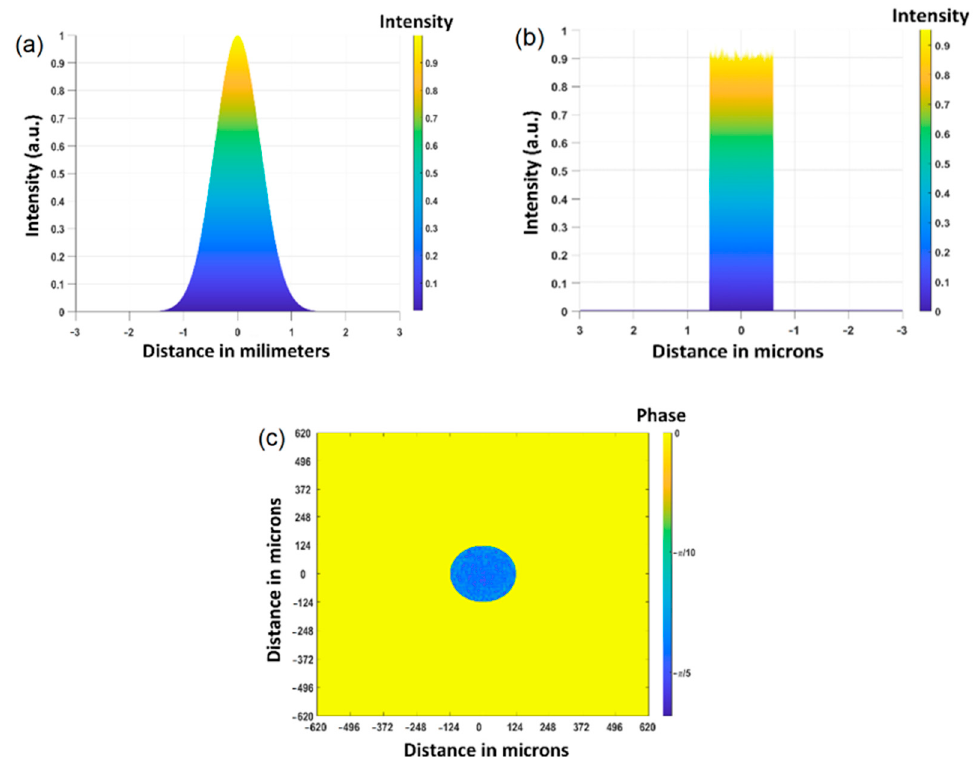
Figure 3. ( a ) Input Gaussian beam; ( b ) output top-hat beam; ( c ) phase distribution of the output top-hat beam.